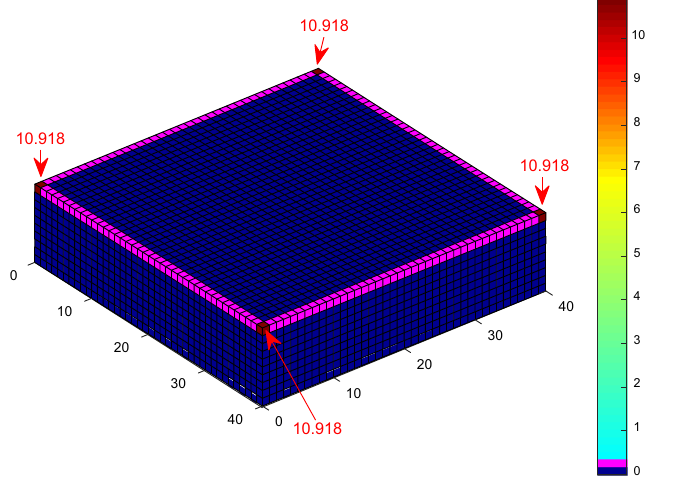
Figure 7. Lightning strike probability to a cuboid using K P2C .